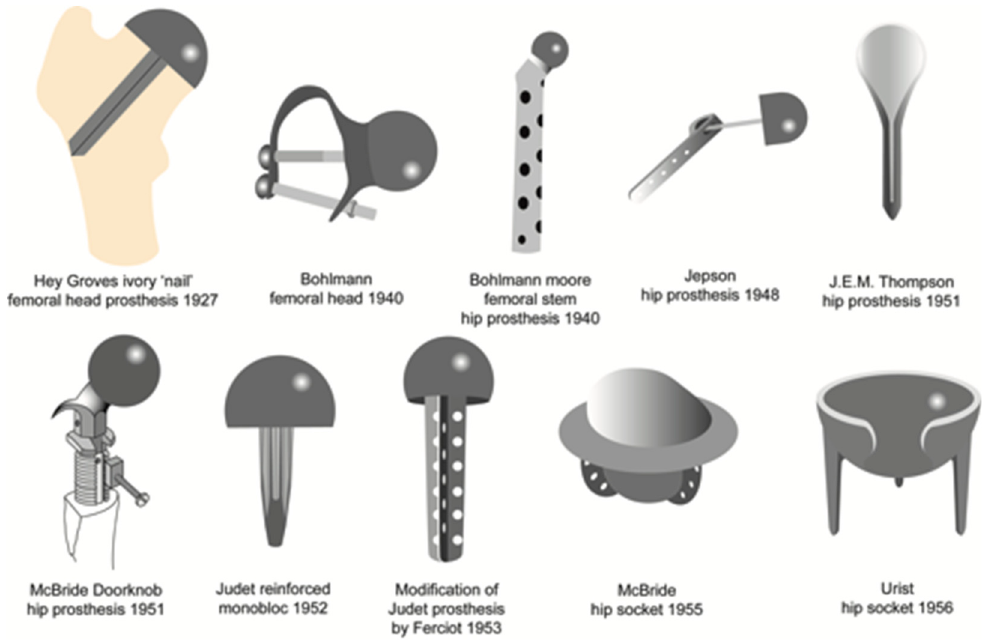
Figure 1. Evolution of the prostheses design.